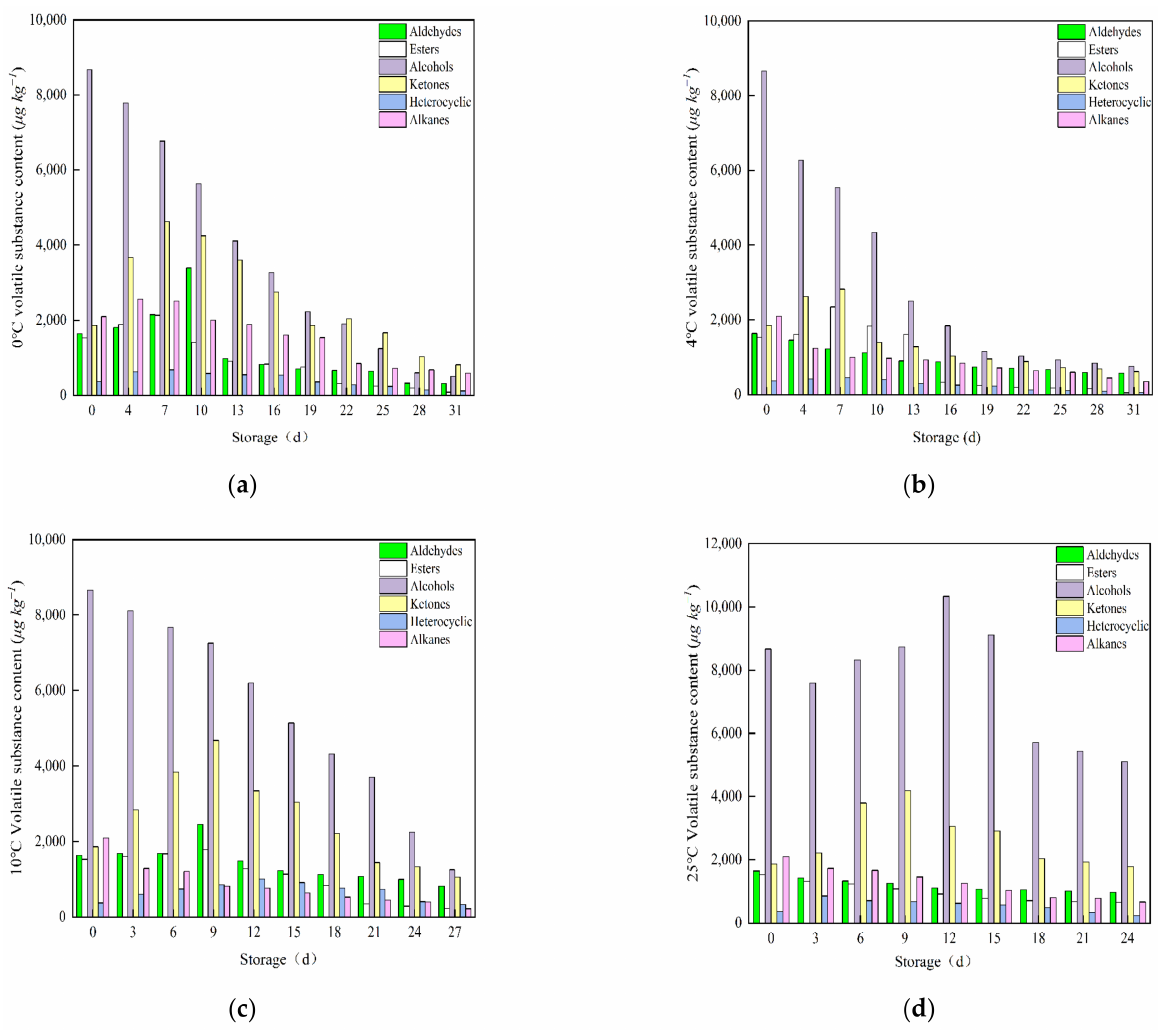
Figure 2. Changes in volatile compounds contents of cherry tomatoes stored at 0 ( a ), 4 ( b ), 10 ( c ) or 25 ◦ C ( d